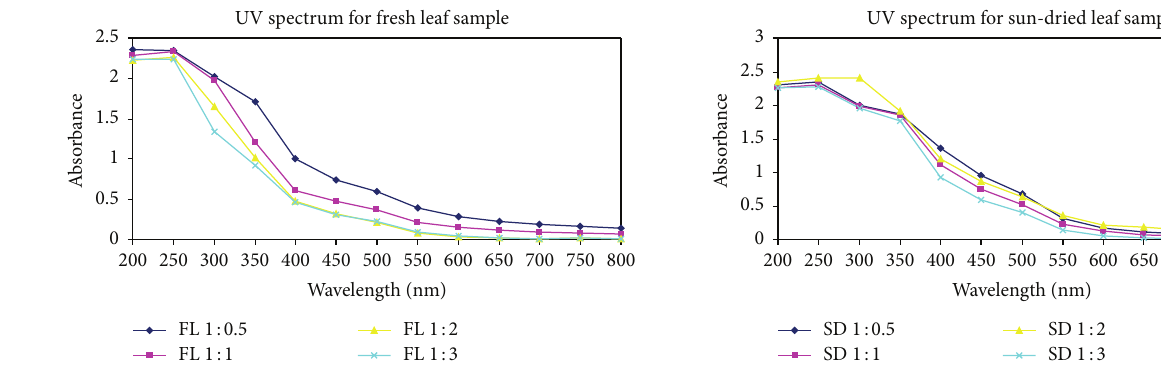
Figure 1: UV-Vis absorption spectra recorded as a function of time of reaction of four different solutions of silver ions by Pimenta dioica fresh leaves extract in ratios of 1: 0.5, 1:1, 1: 2, and 1:3 after 10 minutes reaction kinetics.